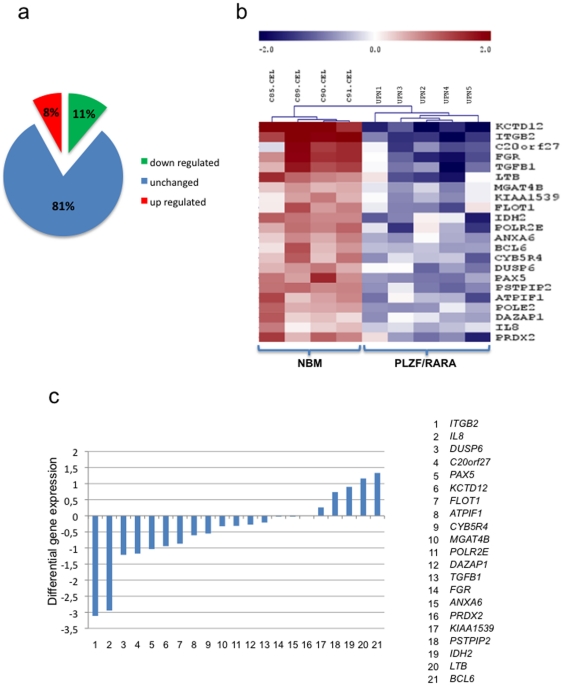
Expression profile of PLZF/RARA target genes.(a) Analysis of variations in PLZF/RARA-direct target gene expression after PLZF/RARA induction in the B412 cell line. (b) Heat map representing mRNA expression levels of PLZF/RARA-direct target genes in PLZF/RARA positive APL samples and normal bone marrow (NBM) samples. Relative expression levels are normalized across the samples; levels greater than or less than the mean are shown in shades of red and blue, respectively. (c) Changes in expression of the 23 genes identified in (b) in response to PLZF/RARA induction in U937-B412 cells. The differential gene expression corresponds to the difference of microarray fluorescence intensity between MT and B412 cell lines for the indicated genes.